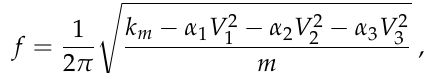
Figure 1. The basic principle of composite springs: (a) Schematic of seismometer structure. Total spring k is given by a sum of mechanical spring k m and electrical spring k e d s which is smaller than the electrode gap d , can prevent electrical short. (b) Behaviors of total spring k = k m + k e